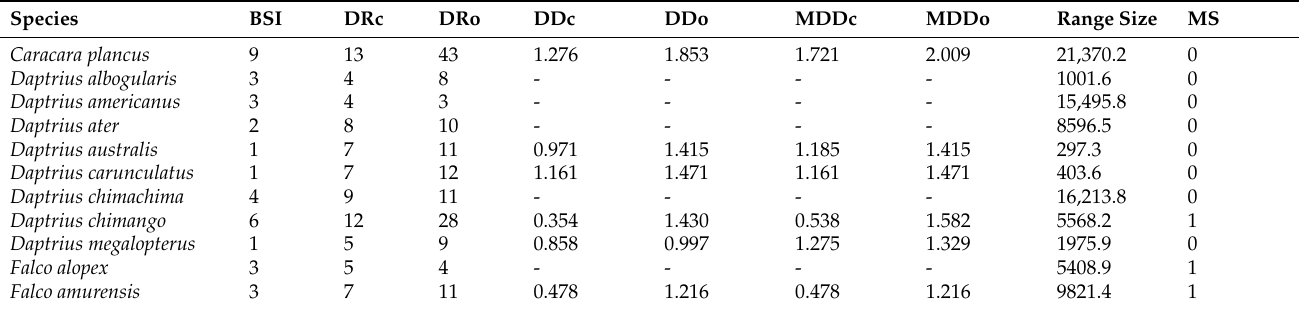
Table A2. Biomic specialisation index (BSI), diet richness (DR), diet diversity (DD), maximum diet diversity (MDD) at class (c) and order (o) taxonomic ranks, range size (Km 2 × 1000) and migratory status (MS; 1 = migratory and 2 = sedentary) of Falconidae species. Falco pelegrinoides was included within F. peregrinus for the study